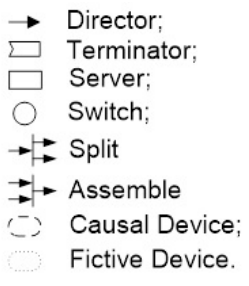
Figure 1. Virtual